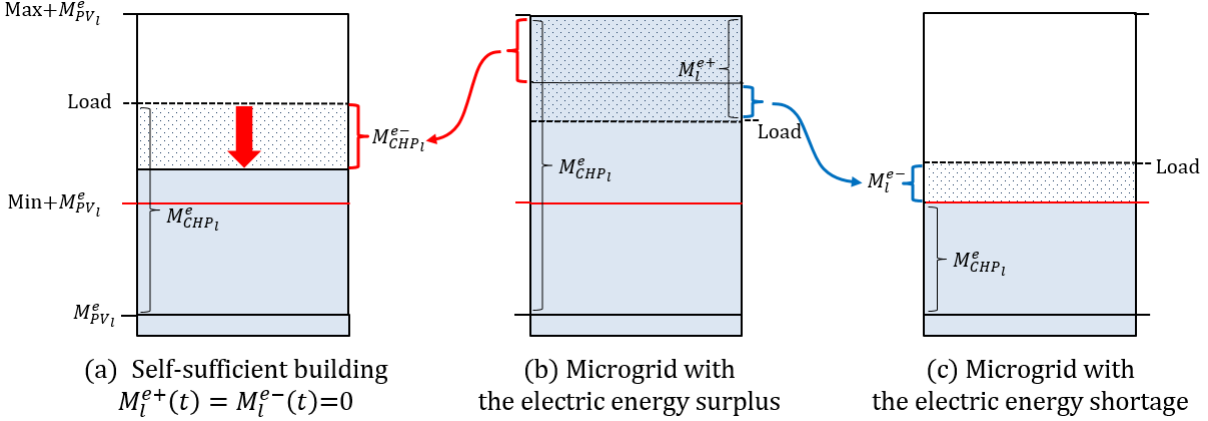
Figure 8. Example of ancillary internal trading when ∑ (cid:1839) (cid:3039)(cid:3032)(cid:2878) (cid:4666)(cid:1872)(cid:4667) (cid:3408) ∑ (cid:1839) (cid:3039)(cid:3032)(cid:2879) (cid:4666)(cid:1872)(cid:4667) (cid:3013) (cid:3039)(cid:2880)(cid:2869)(cid:3013)